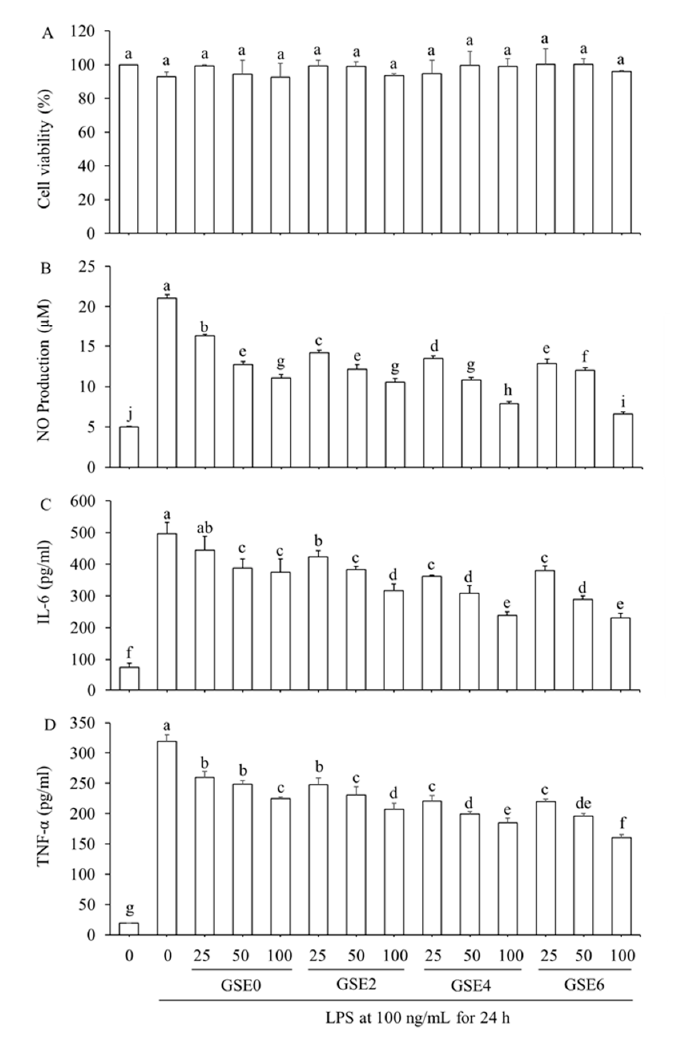
Figure 4 . Effects of GSEs steamed for different times (0–6 h) on viability, nitric oxide (NO) production and the levels of two inflammatory cytokines in lipopolysaccharide (LPS)-induced RAW264.7 cells. ( A ) Relative cell viability; ( B ) NO production; ( C ) interleukin (IL)-6 level; and ( D ) tumor necrosis factor (TNF)- α level. RAW264.7 cells were pretreated with various concentrations (25, 50, or 100 µg mL − 1 ) of GSE0, GSE2, GSE4, or GSE6 or vehicle for 2 h and then treated with 100 ng mL − 1 LPS for 24 h. Results are representative of three independent experiments and are presented as means ± SD. Different letters indicate significant differences at p < 0.05 based on Duncan’s multiple range test.